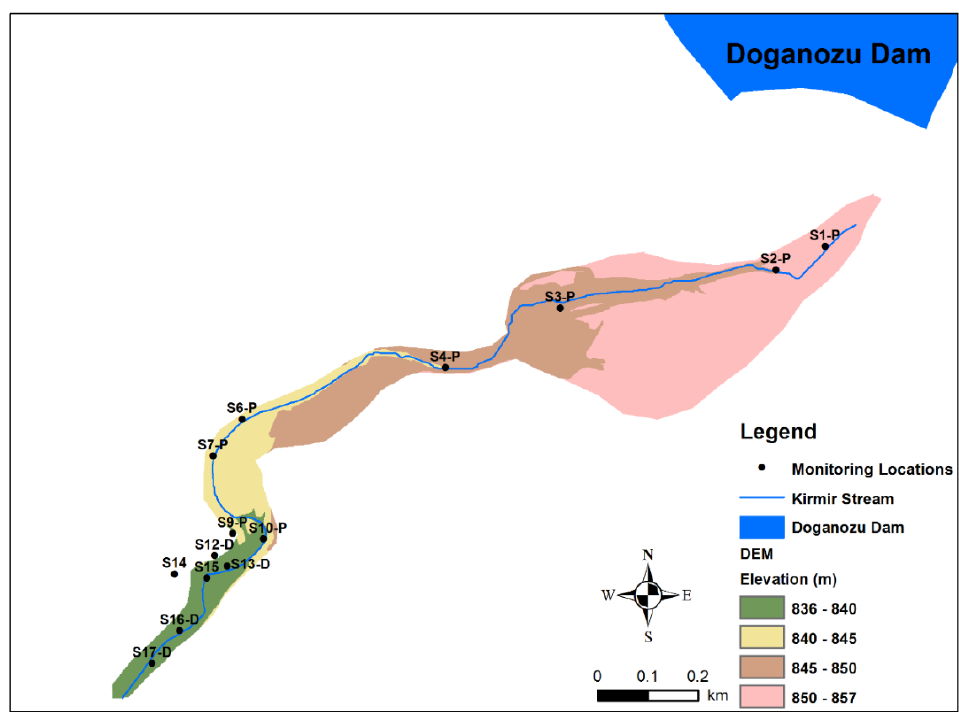
Figure 2. Monitoring locations along the study reach.